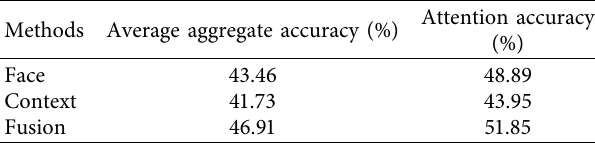
Table 3: Performance evaluation of attention and feature